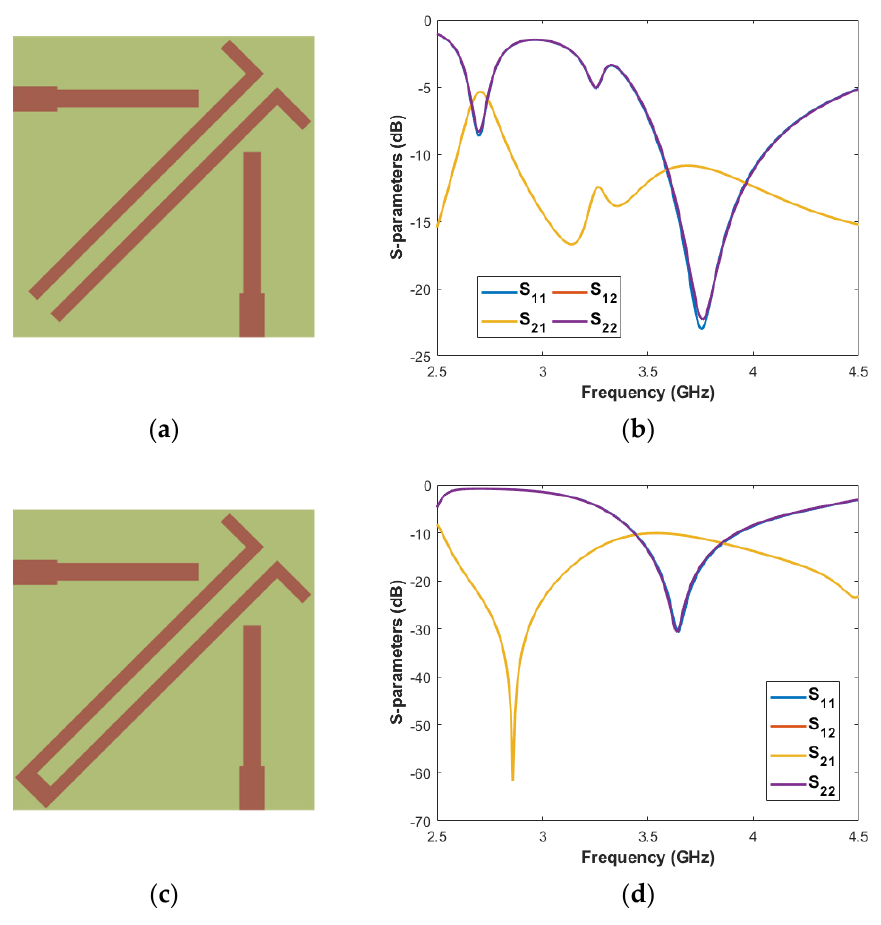
Figure 5. Decoupling element design to improve isolation: ( a ) L-shaped stubs are placed between the radiating elements and ( b ) the S-parameters curved are presented; ( c ) the L-shaped stubs are connected by a microstrip line and ( d ) the S-parameters curves are